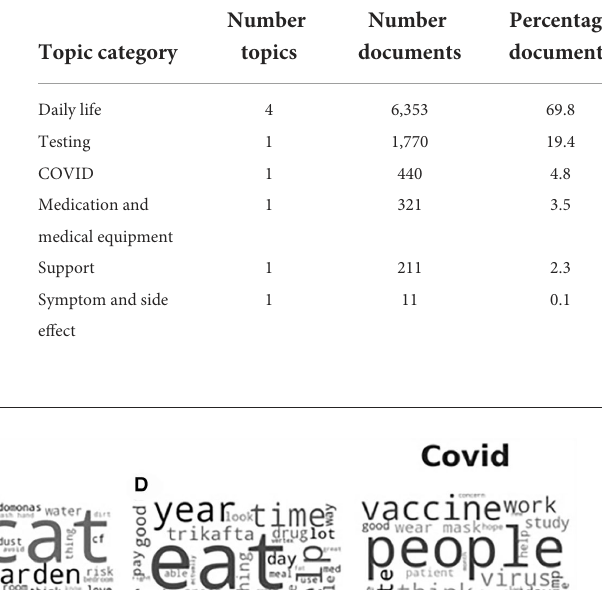
TABLE 1 Topic size and category names for the 9 derived topics from the Latent Dirichlet Allocation (LDA) model with the highest coherence.